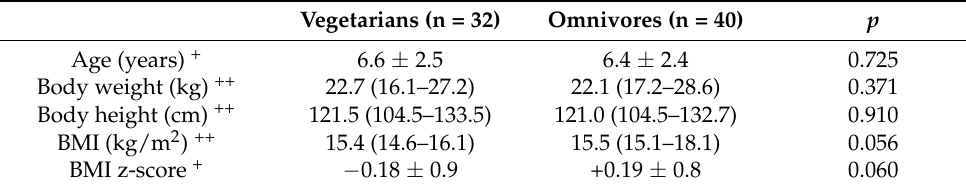
Table 1. Anthropometric parameters in vegetarian and omnivorous